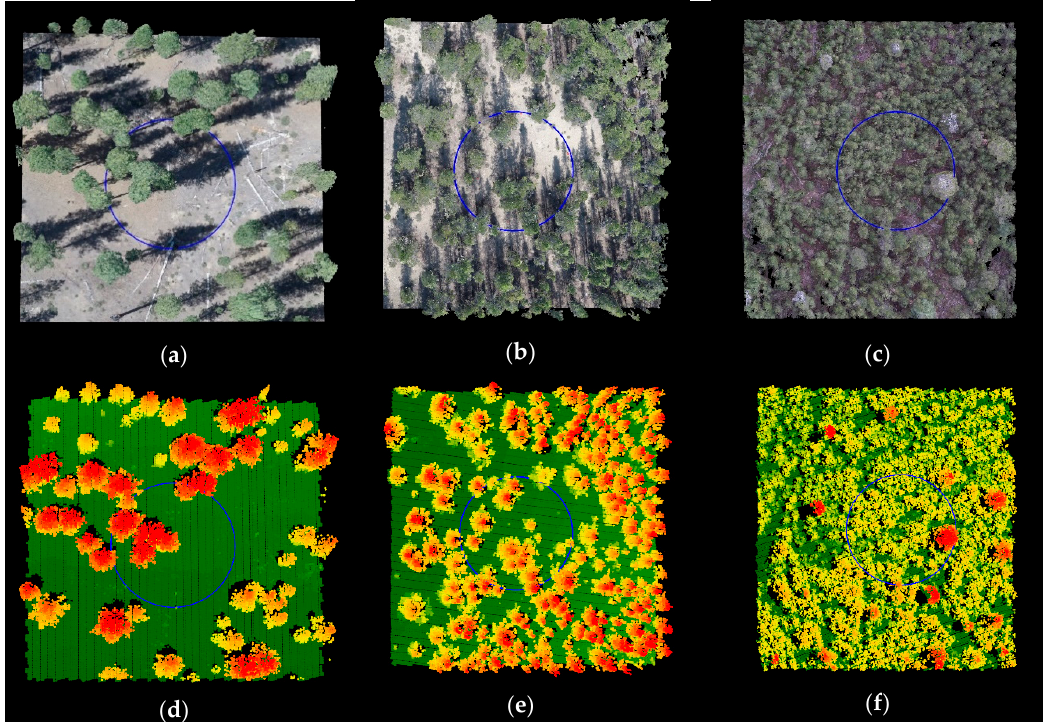
Figure 3. Nadir views of 3D representations produced by unmanned aerial system (UAS)- and airborne laser scanning (ALS)-derived methods, respectively, from one plot in each canopy cover between ( a , d ) 10–40%; ( b , e ) 40–70%; and ( c , f ) 70–100%. The point clouds from imagery collected with the UAS are displayed in red, green, blue (RGB) while the point clouds obtained from ALS are colored according to aboveground height. The blue circle represents the boundary of the 16.2-m radius plot.